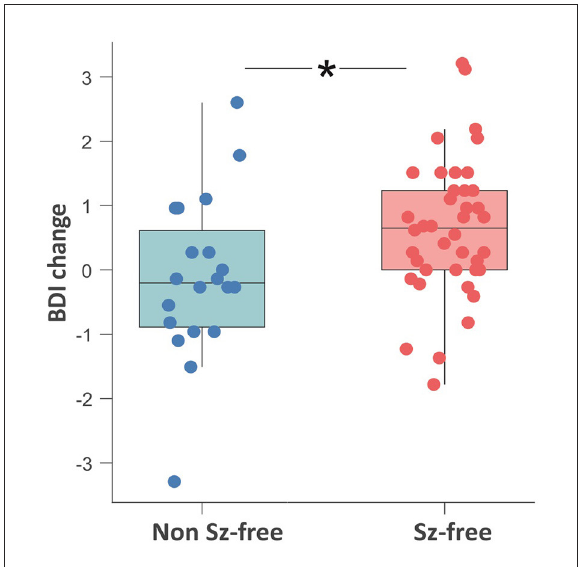
FIGURE2 Boxplot showing the comparison of the pre- to postoperative change in depressive symptoms between the seizure-free (red) and non-seizure-free patients (blue). Change scores on the y-axis are computed as z-score postoperative minus z-score preoperative . Negative values on the y-axis represent a postoperative increase of depressive symptoms. * p < 0.05; ns, non-significant; Sz, seizure; BDI, Beck Depression